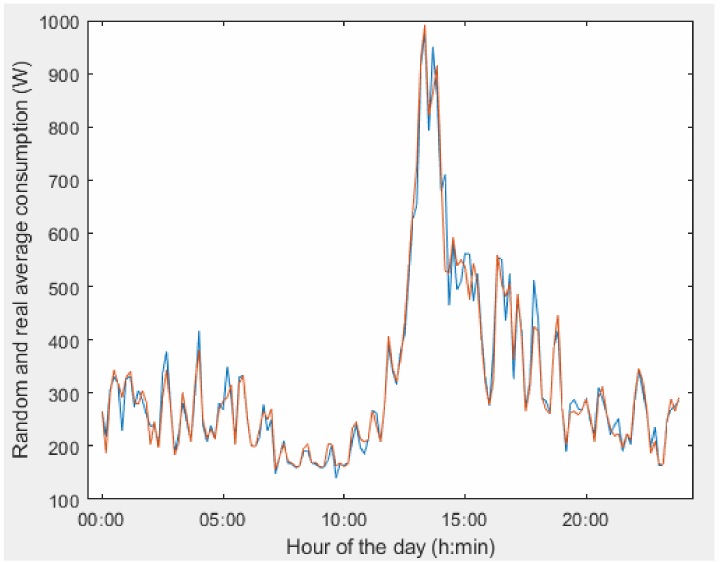
Figure 10. Random (blue) and real (orange) average consumption of HVAC during working days.